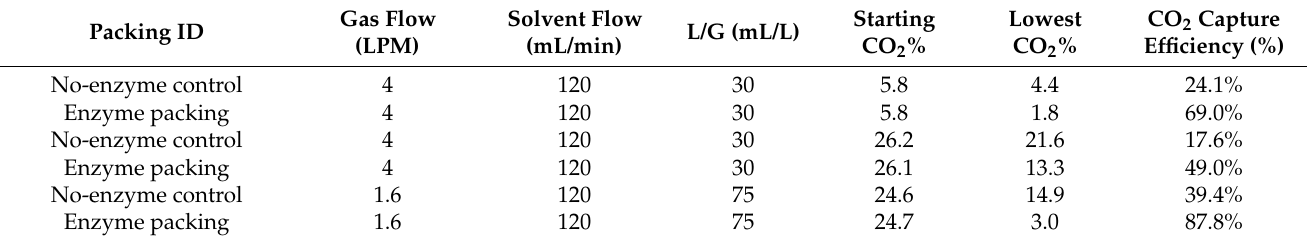
Table 6. CO 2 capture efficiencies of no-enzyme textile control packing and enzyme immobilized textile structured packing at low and high CO 2